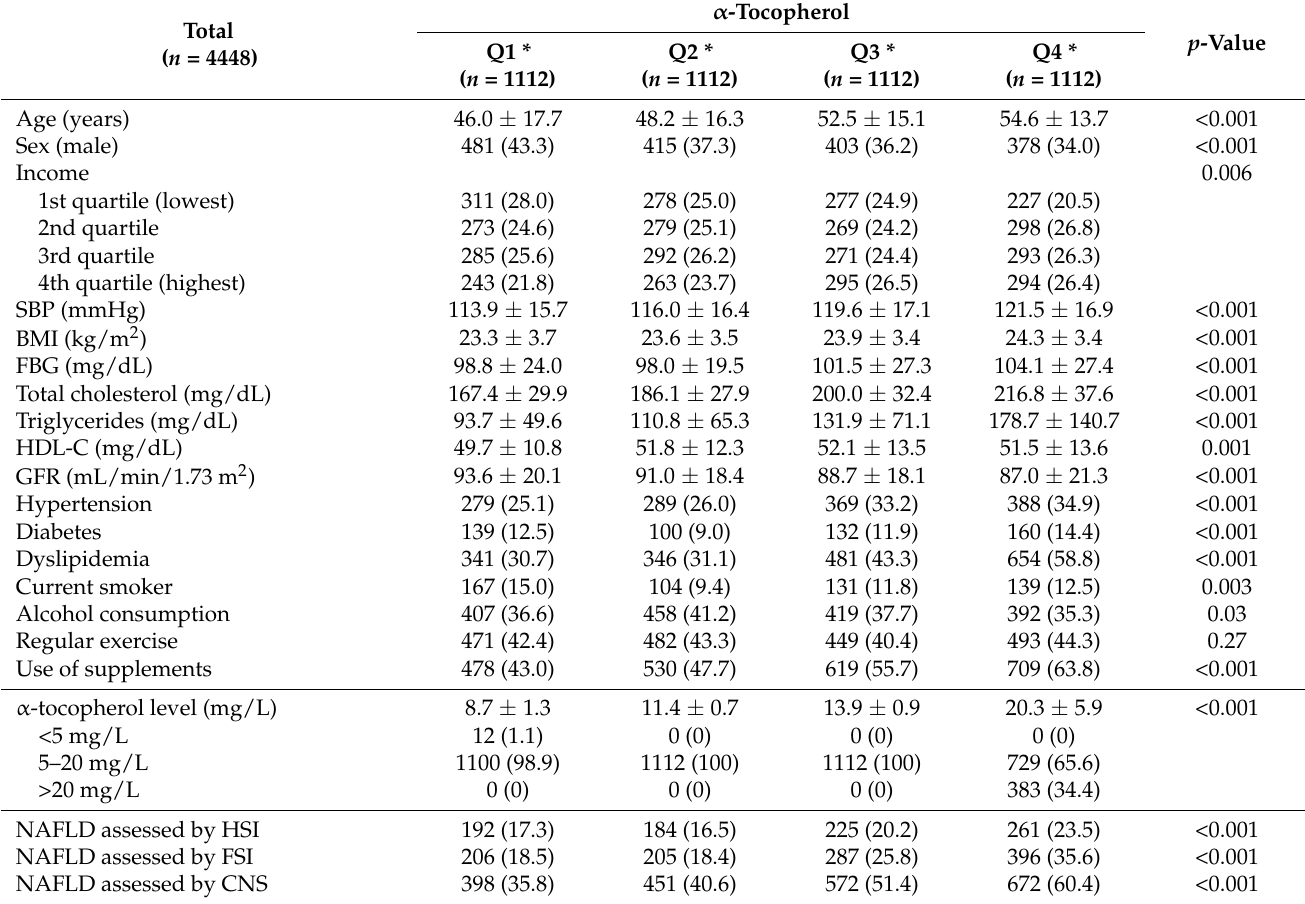
Table 2. Characteristics of subjects according to quartile group for alpha ( α